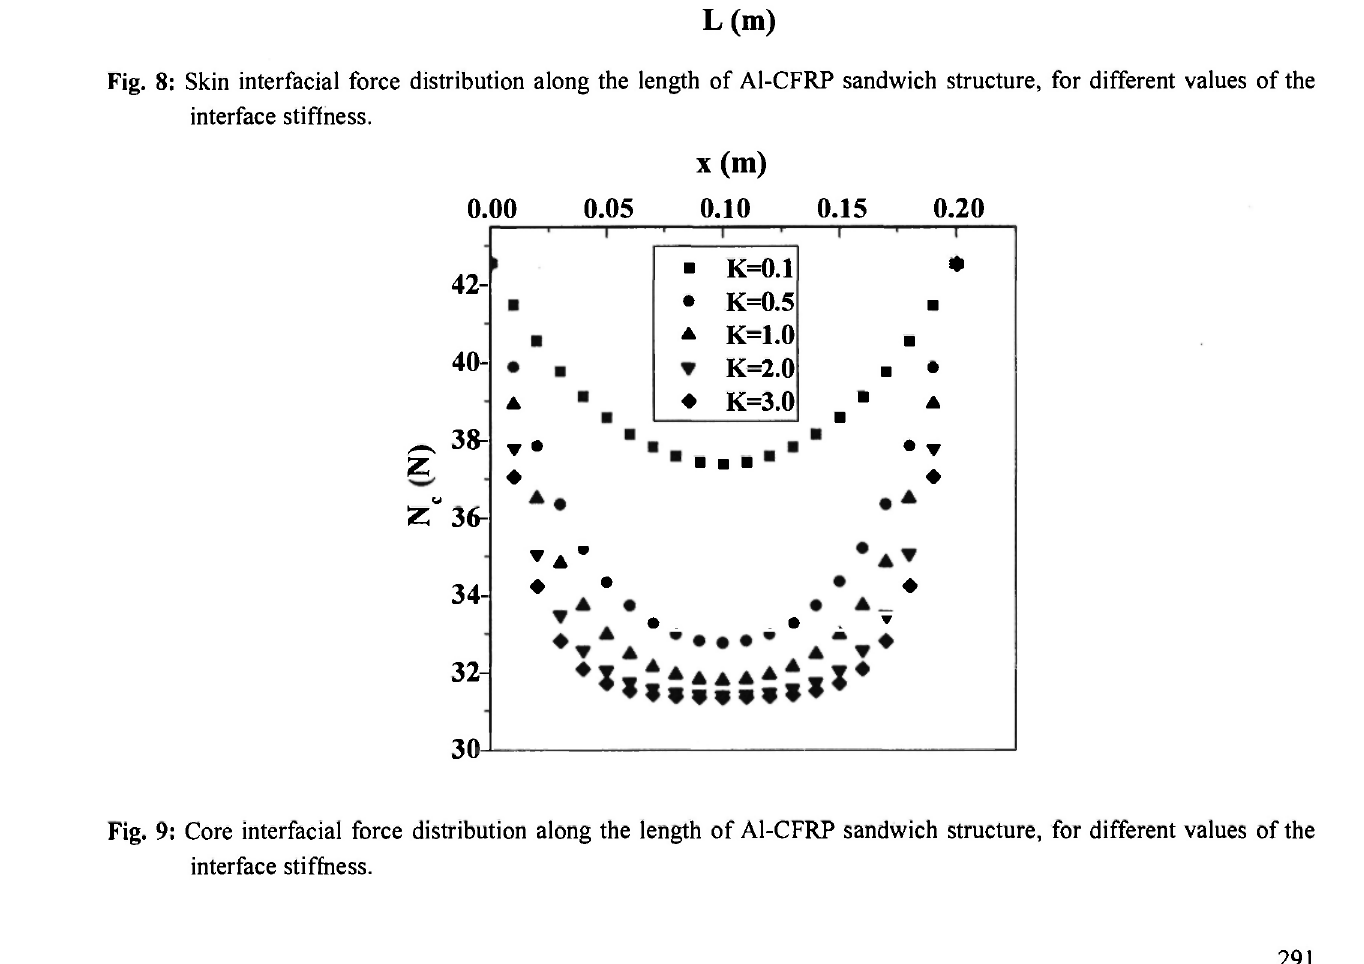
Fig. 9: Core interfacial force distribution along the length of Al-CFRP sandwich structure, for different values of the interface